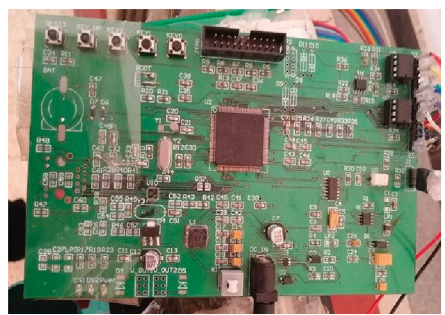
Figure 3: Main control board.